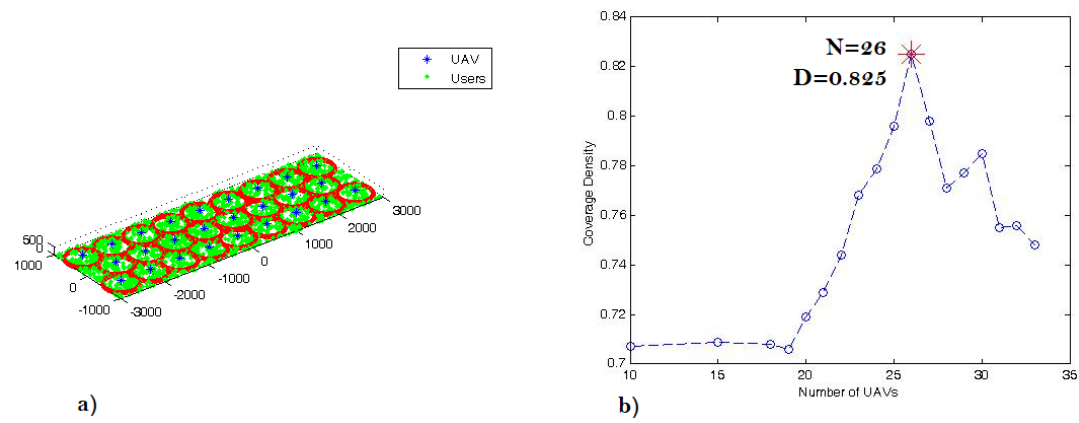
Figure 9. ( a ) Top 3D view of the users distribution and the UAVs’ placement inside the coverage area 6 km × 1.8 km; ( b ) the coverage density for packing n identical circles inside the coverage area.